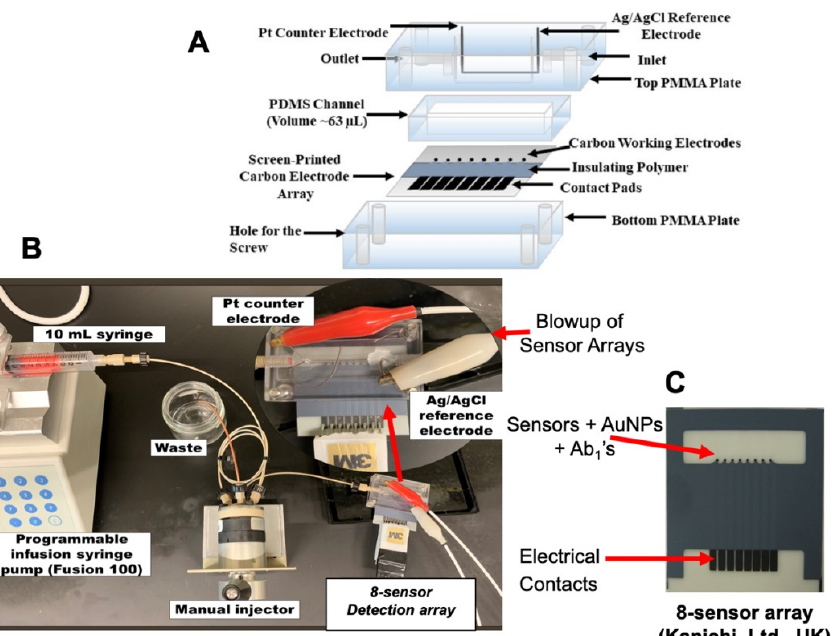
Figure 2. Electrochemical immunoarray for protein detection showing ( A ) exploded view of mi- crofluidic detection channel featuring molded polydimethylsiloxane (PDMS) channel enclosing and 8-sensor array and Ag/AgCl reference and Pt-wire counter electrodes running the full length of the channel, ( B ) full microfluidic system showing programmable syringe pumps, injector, and 8-sensor array, and ( C ) Kanichi 8-carbon sensor array coated with Au-nanoparticle layers and attached capture antibodies.